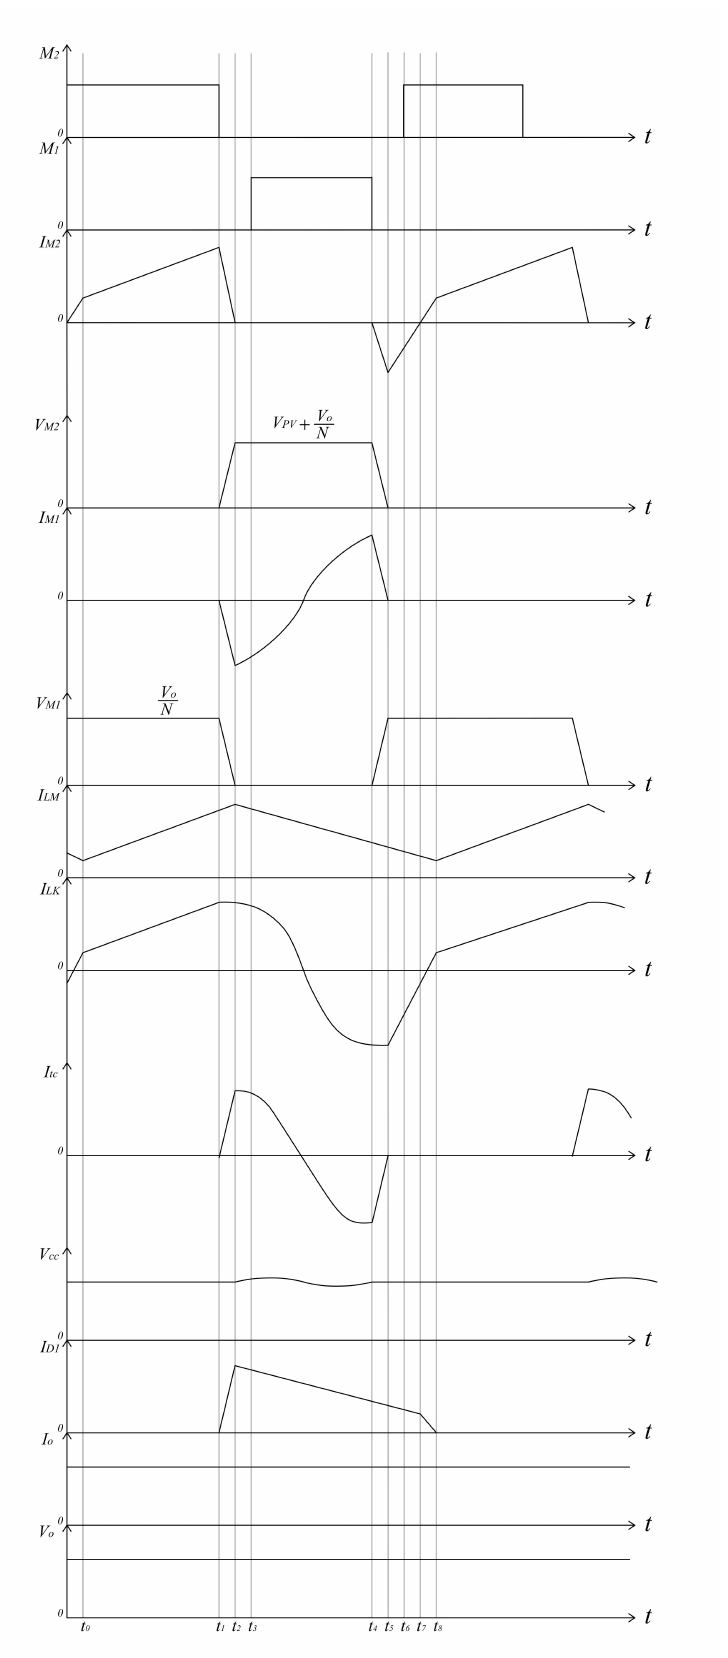
Figure 10. Conceptual waveforms of the propose hybrid converter operated in the discharging